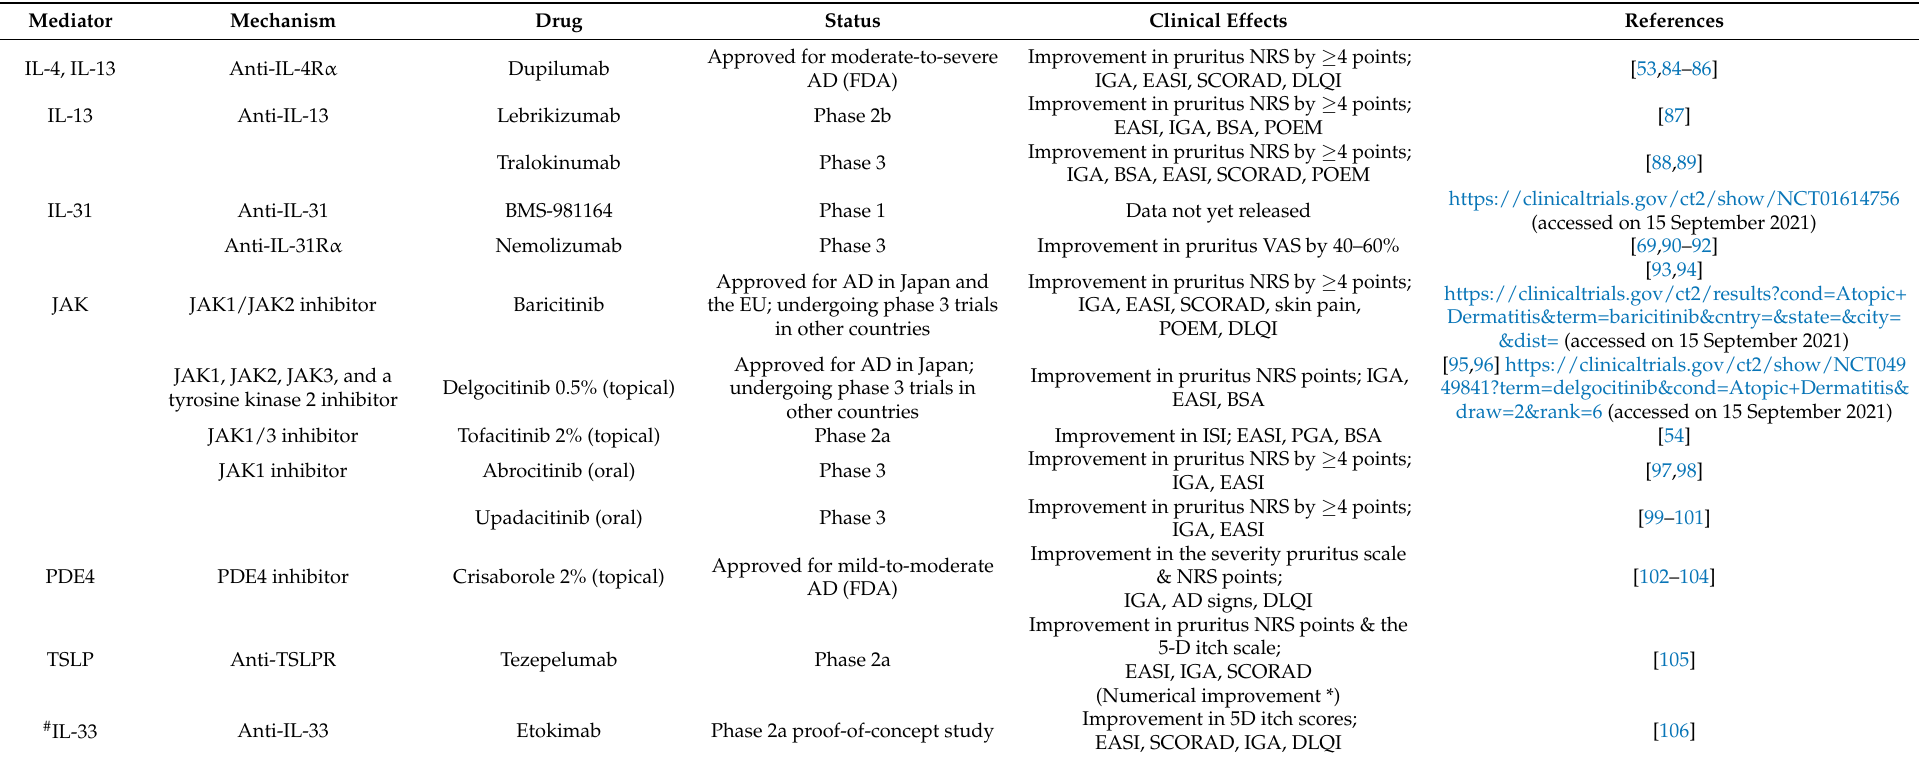
Table 1. Therapeutic potential of the biologic agent-type 2 inflammation-related regulation of itch in atopic